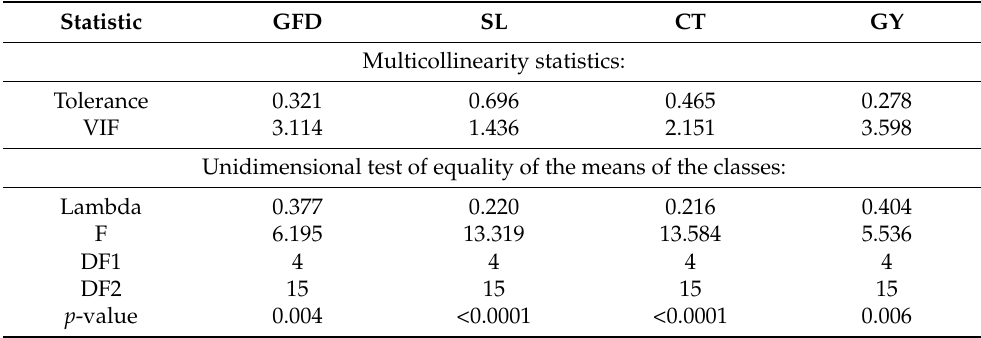
Table 7. Multicollinearity statistics and unidimensional test of equality of the means of the classes of heat group to canonical discriminant function.